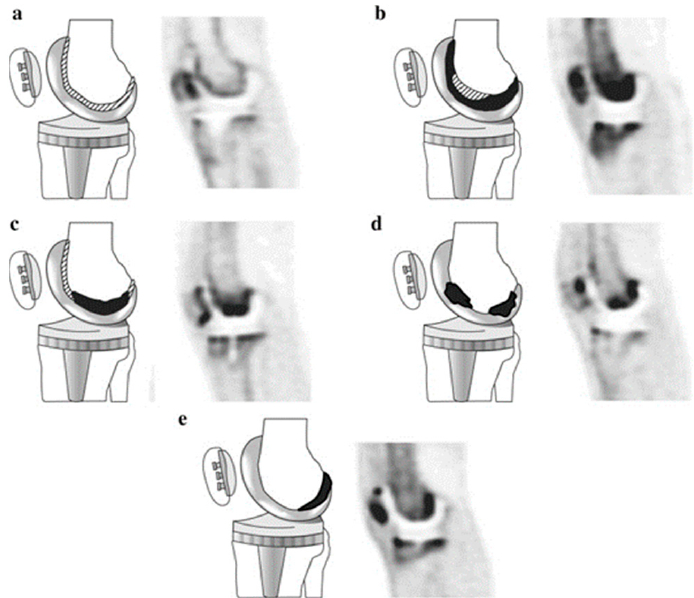
Figure 6. Diagrams and representative PET images showing the five types of 18 F-NaF uptake pattern in the femoral component of knee prostheses. Black areas represent areas of severely increased uptake and shaded areas represent slightly increased uptake of radiotracer. Adapted with permission from Son et al. (2016) [50] Copyright Springer Nature, 2016.